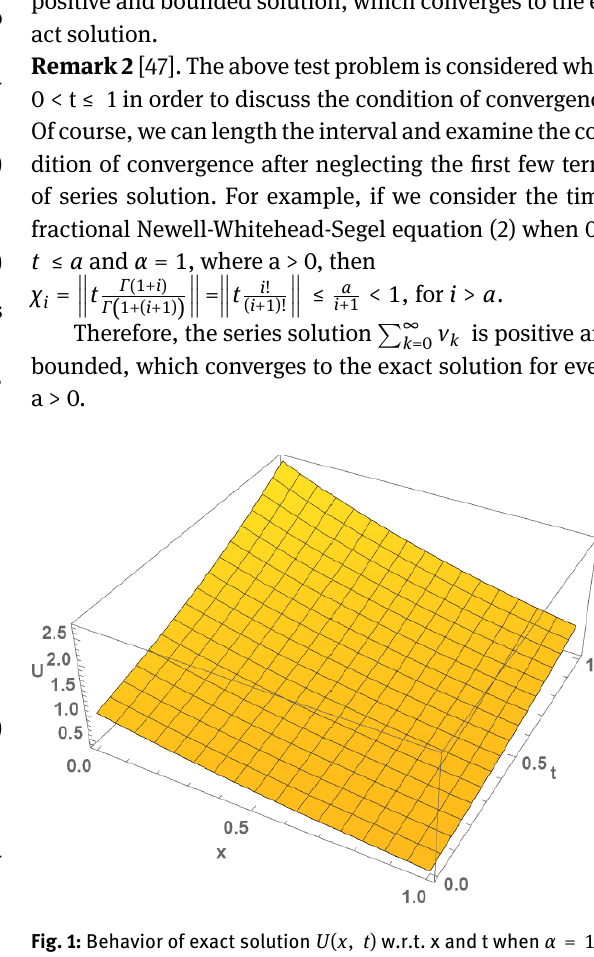
Fig. 1: Behavior of exact solution U ( x , t ) w.r.t. x and t when α = 1 for Eqs.